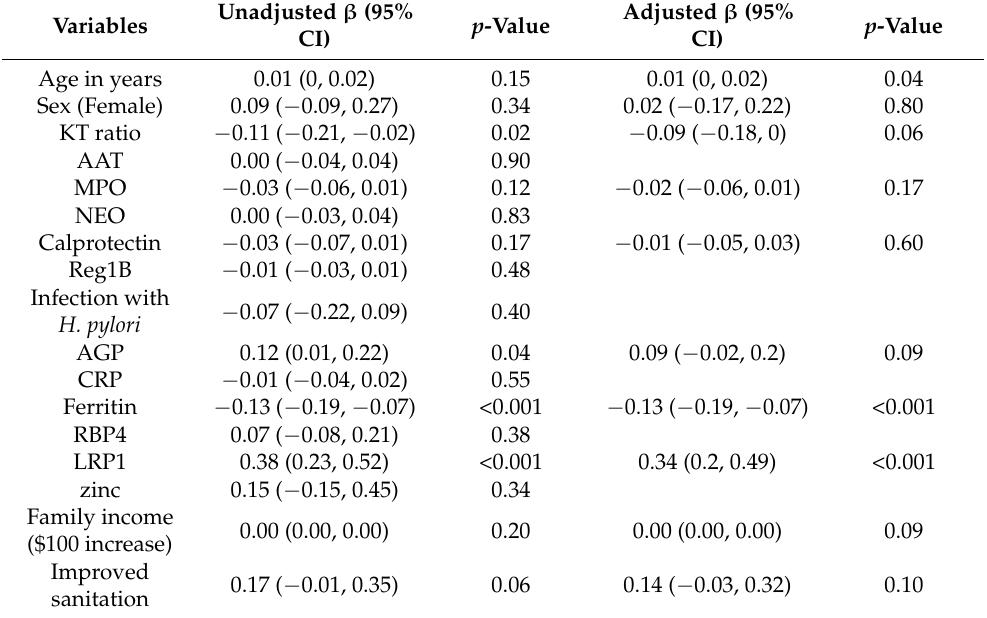
Table 2. Association of the KT ratio and other variables with body mass index using a generalized estimating equation at baseline and endline ( n =